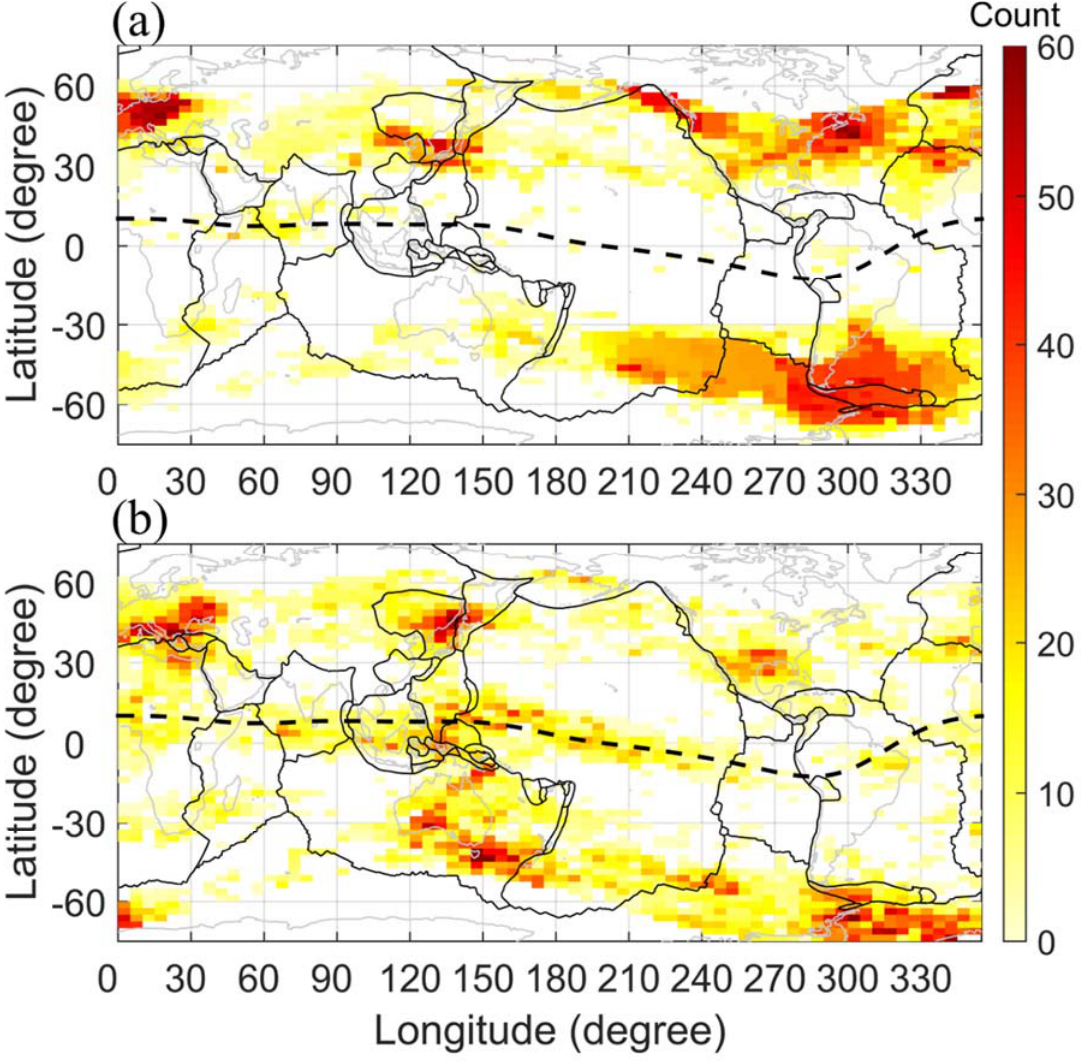
Figure 4. Distribution of the ( a ) negative and ( b ) positive TEC anomalies persisting longer than 24 h. The dashed curve denotes the magnetic equator. The gray and black lines, respectively, sketch the coast and the boundaries of the tectonic plates.